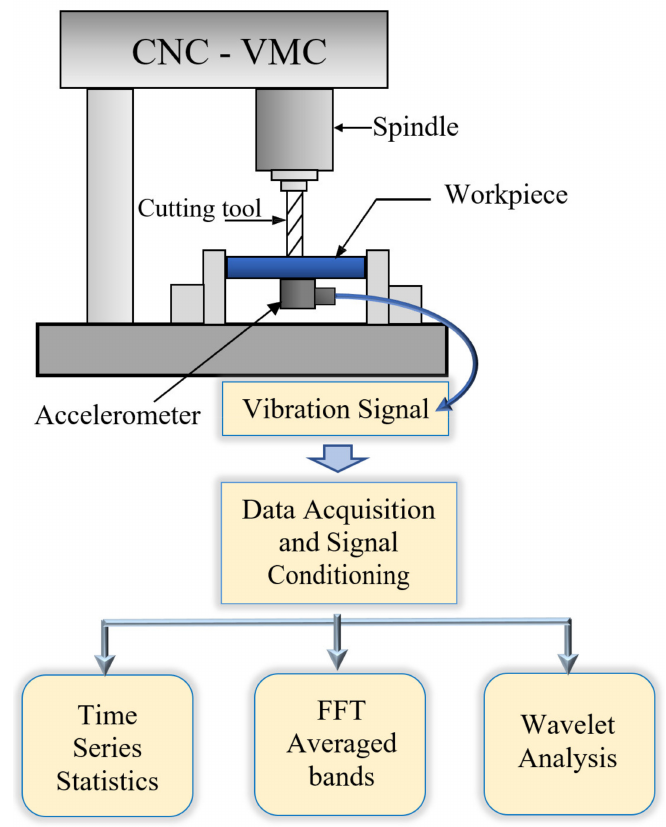
Figure 1. Schematic diagram of the end milling experimental set-up.